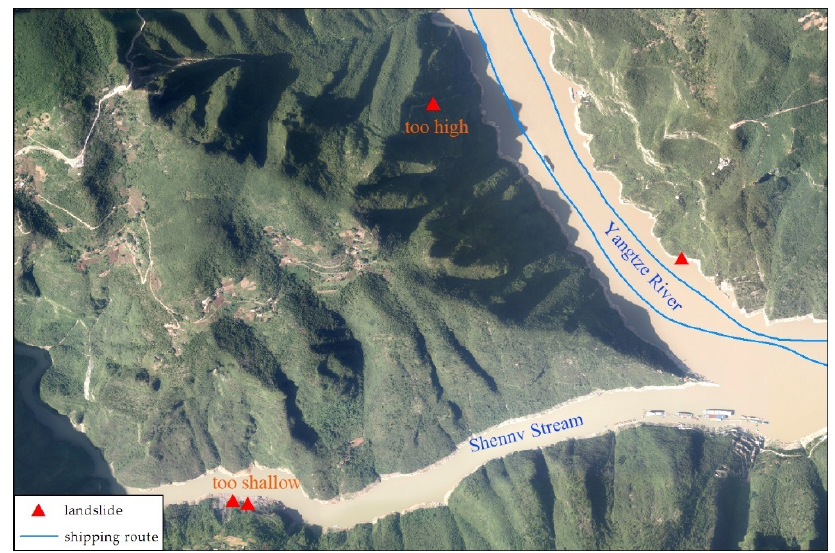
Figure 16. Example of the shortcomings of shipborne mobile photogrammetry.